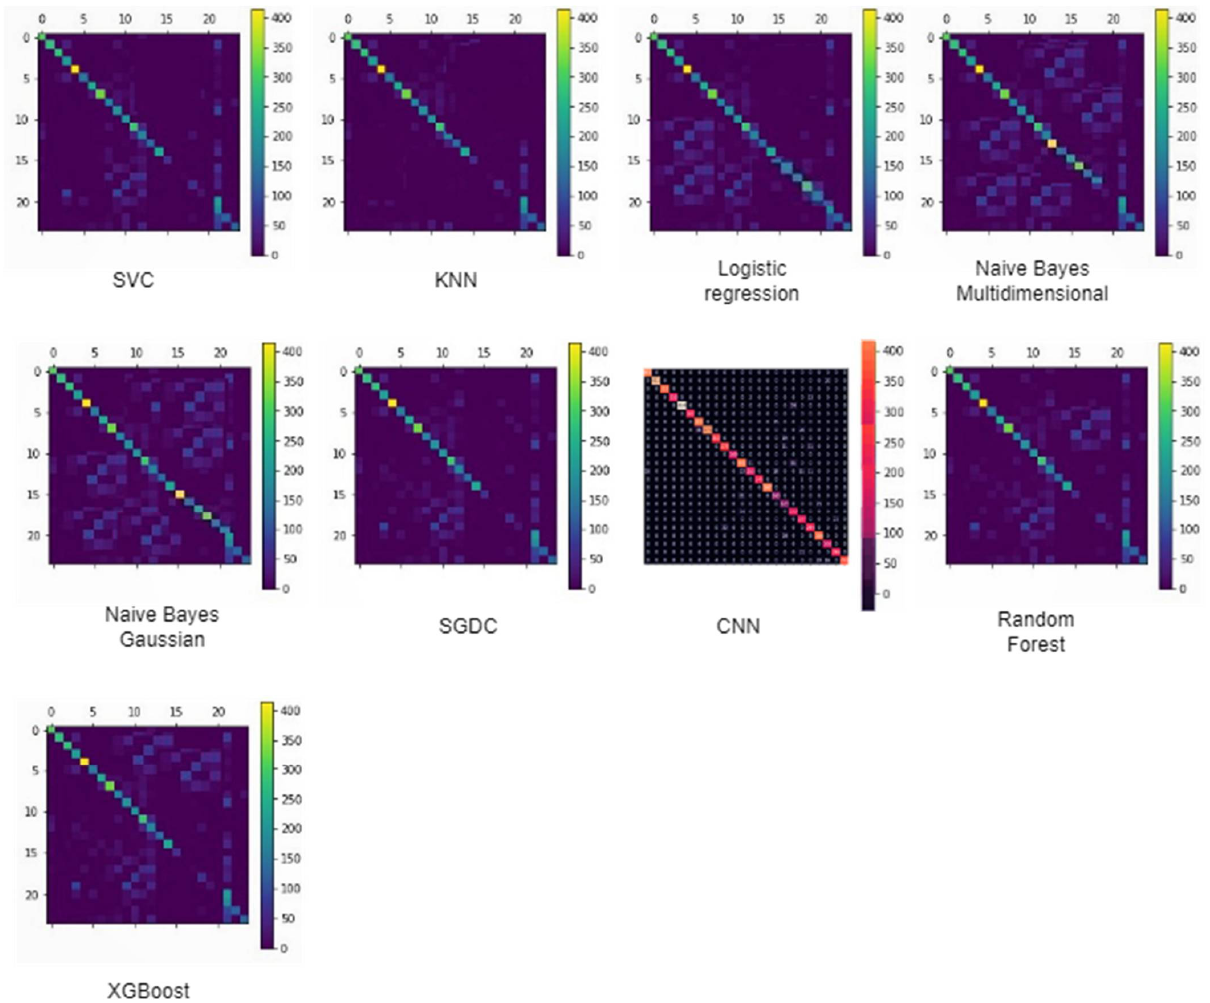
Figure 2. Confusion matrix of analysis using SVC, KNN, logistic regression, Naïve Bayes Multinomial, Naïve Bayes Gaussian, SGDC, CNN, random forest, and XGBoost.